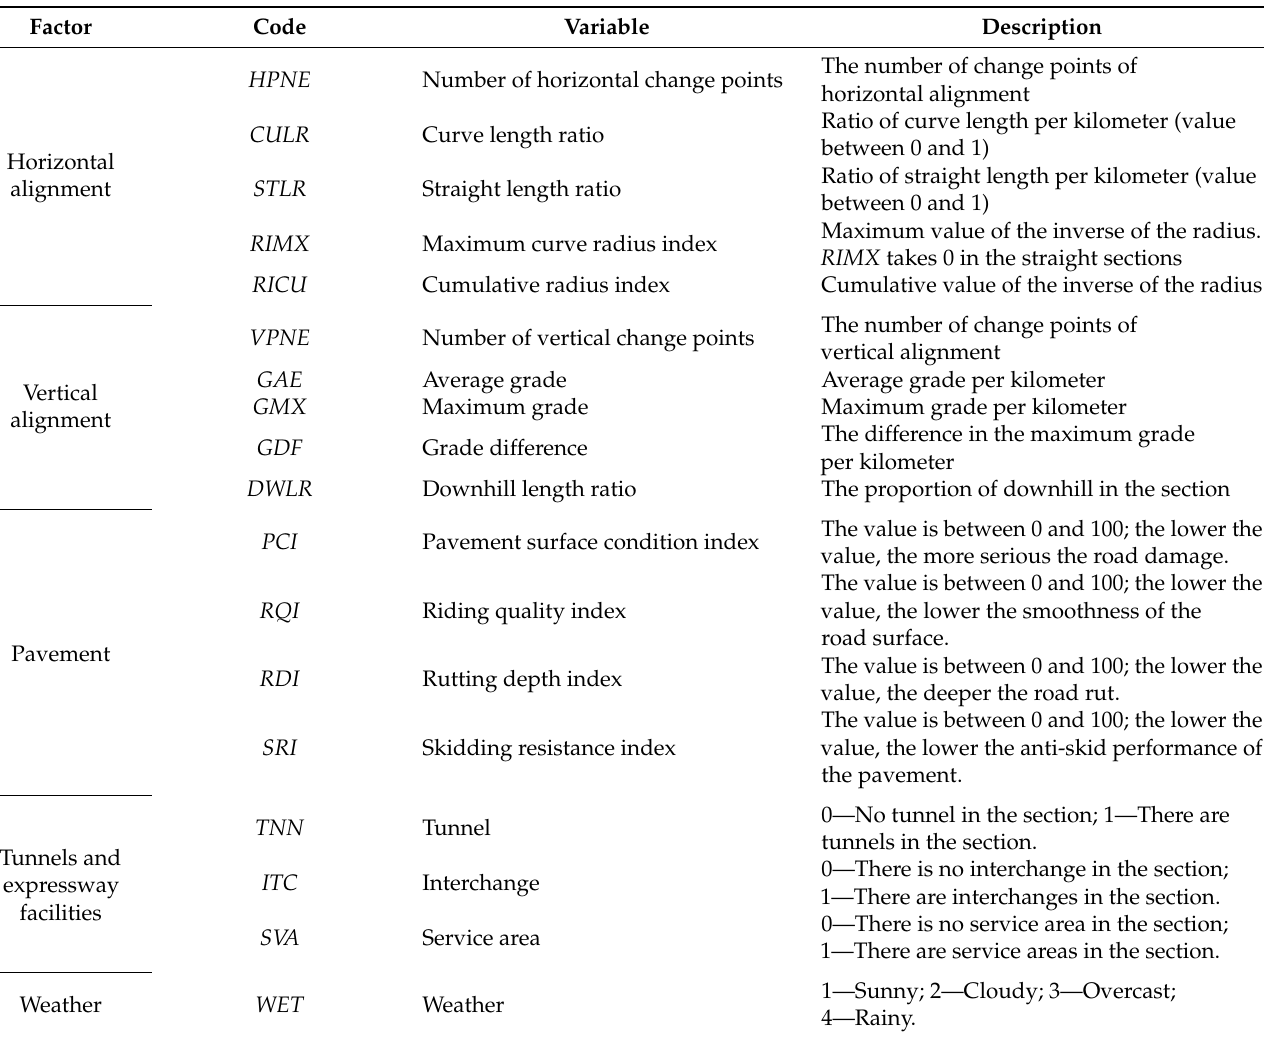
Table 2. Overview of the feature variables used in this